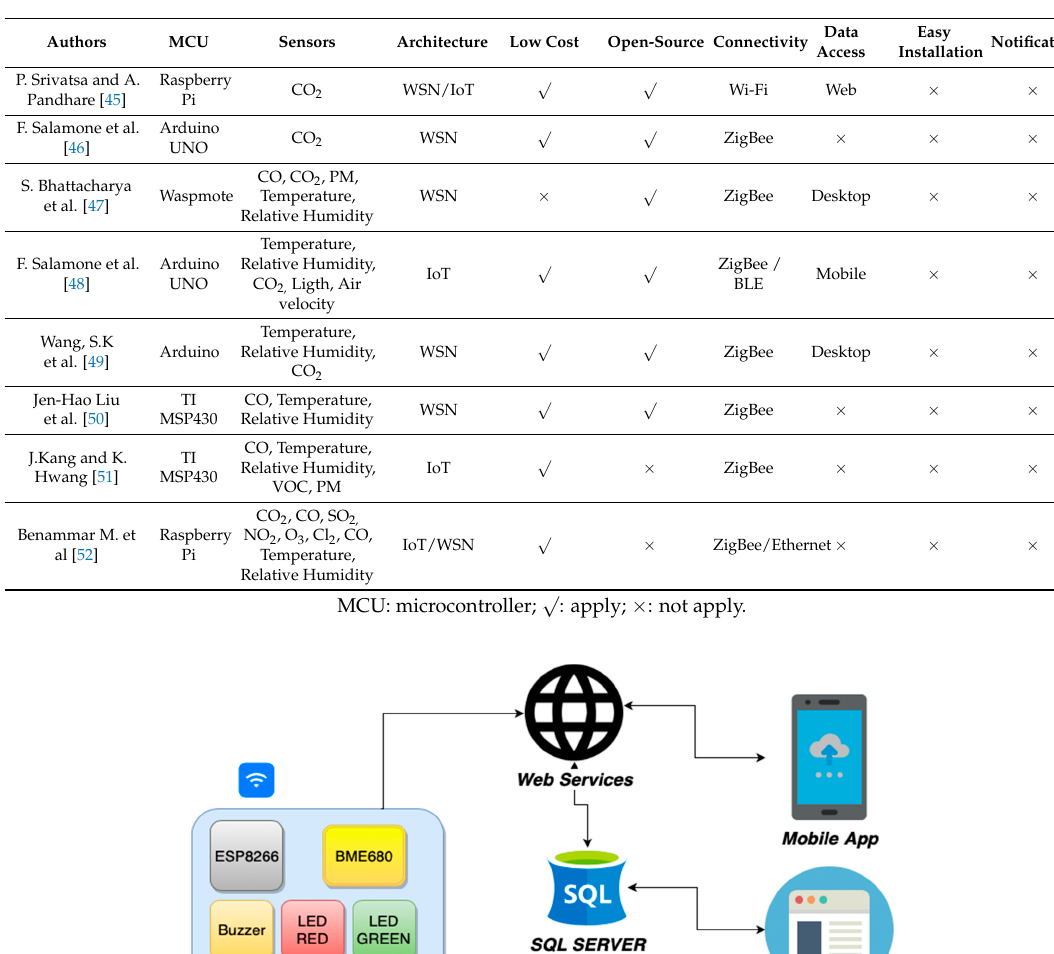
Table 1. A summary comparison of real-time IAQ monitoring studies.